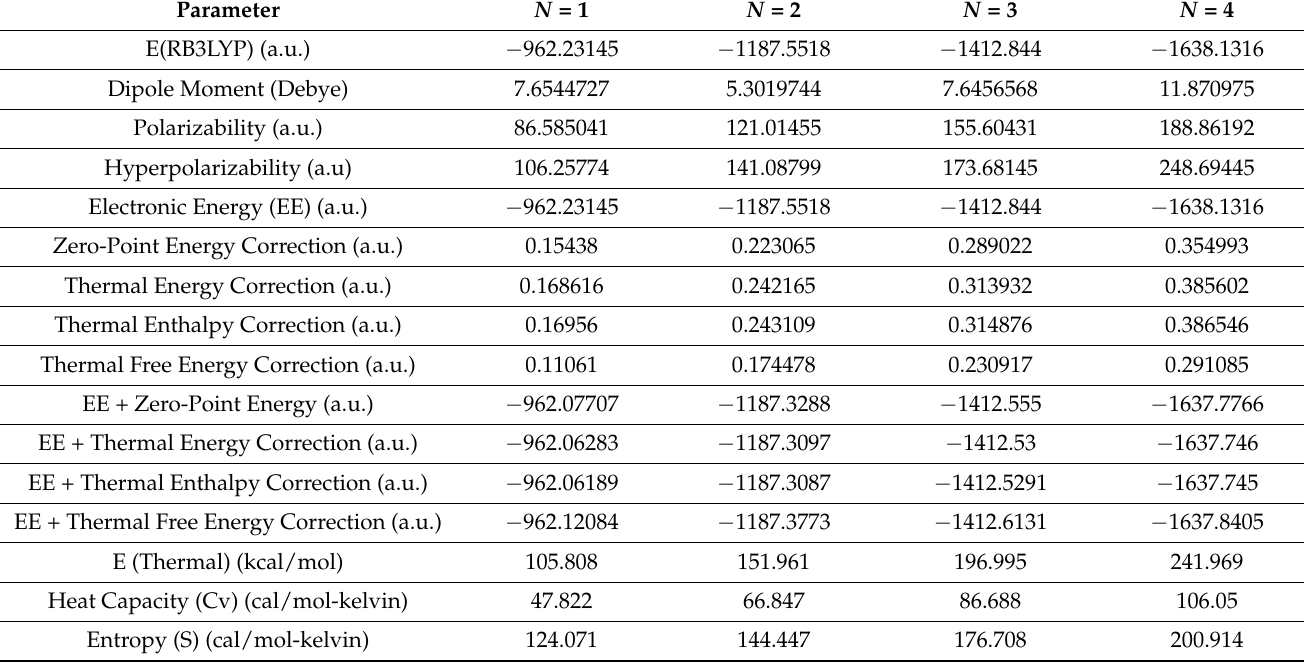
Table 7. Thermodynamic parameters of ammonium sulfamate–urea systems with different